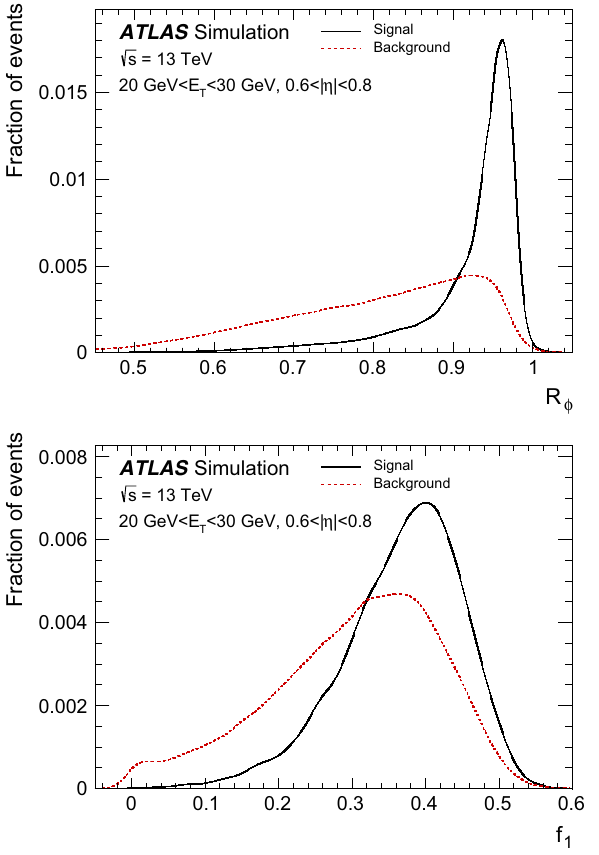
Fig. 7 The f 3 (top) and R had (bottom) pdf distributions in data and simulation for prompt electrons that satisfy 30 GeV < E T < 40 GeV and 0 . 80 < | η | < 1 . 15. The distributions for both simulation and data are obtained using the Z → ee tag-and-probe method. KDE smoothing has been applied to all distributions. The simulation is shown before (shaded histogram) and after (open histogram) applying a constant shift ( f 3 , top) and a width-scaling factor ( R had , bottom). Although some | η | bins of f 3 additionally have a width-scaling factor, this particular | η